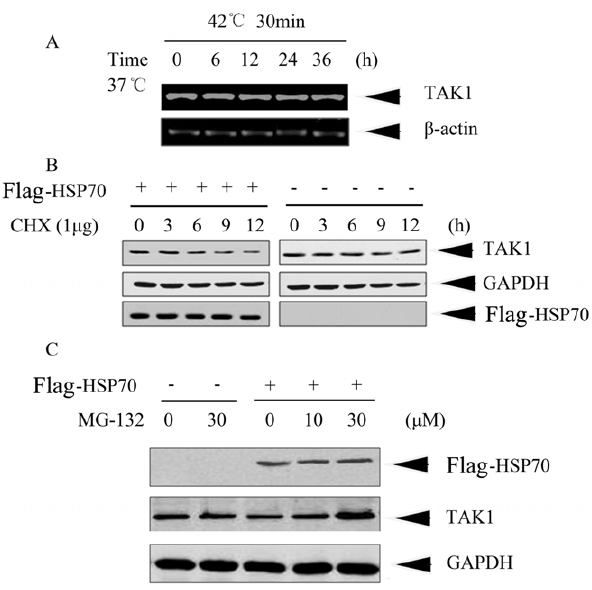
Figure 3. HSP70 destabilized TAK1 at protein level via proteasome pathway. (A) HeLa cells were exposed to a mild heat shock (42 u C for 30 min) followed by recovery at 37 u C for indicated time periods. Total RNA was isolated and TAK1 mRNA was detected by RT- PCR using primers indicated in Materials and Methods. b -actin was used as control. (B) HeLa cells were transfected with pcDNA3.0-Flag-HSP70 ( + ) or pcDNA3.0 ( 2 ). After 48 h, cells were treated with 1 m g/ml cycloheximide (CHX) and harvested at indicated time points. TAK1 protein levels were determined by Western blotting, GAPDH was used as loading control, and antibody against Flag-tag was used to show the overexpression of HSP70. (C) HeLa cells were transfected with pcDNA3.0-Flag-HSP70 ( + ) or pcDNA3.0 ( 2 ). After 48 h, cells were treated with a proteasome inhibitor MG-132 at indicated concentra- tions for 6 h. Cells were collected and subjected to immunoblot analysis with TAK1 antibody. Equal loading protein was confirmed by immunoblotting with anti-GAPDH